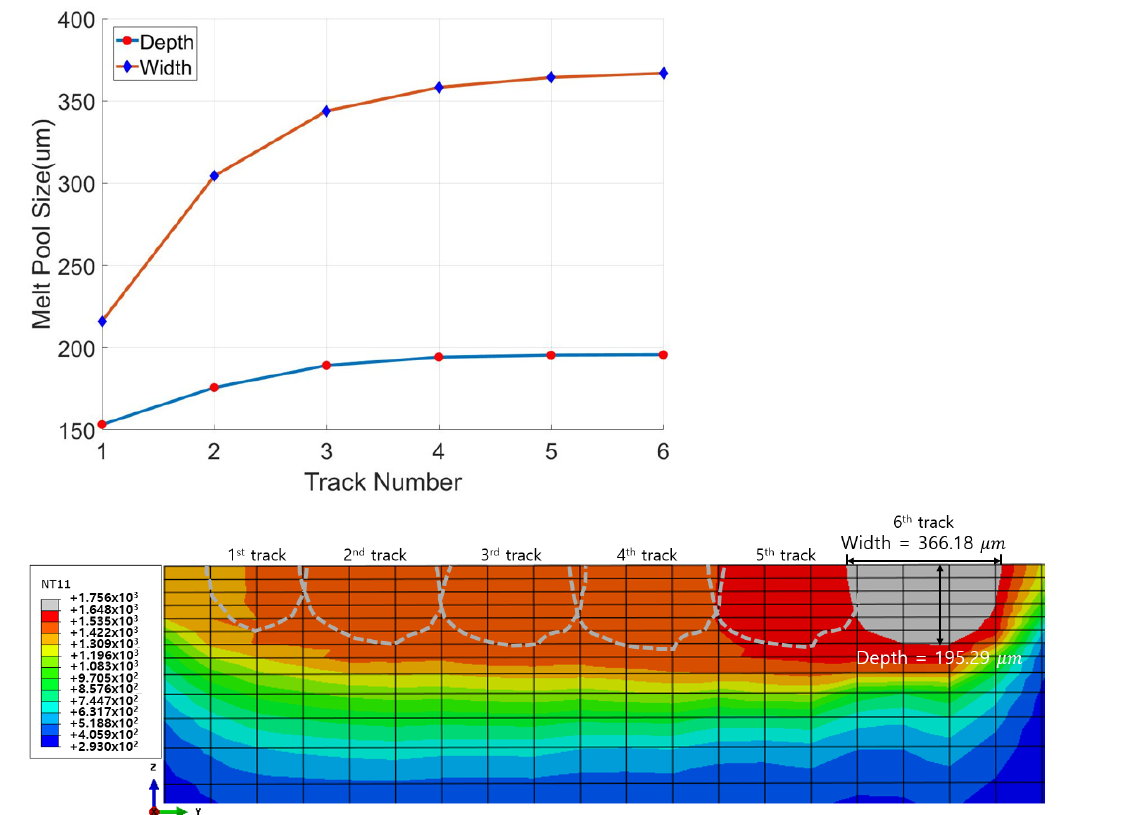
Figure 2. Melt pool size with respect to number of tracks. Table 1. Process and analysis parameters used in the analysis of Figure 2.